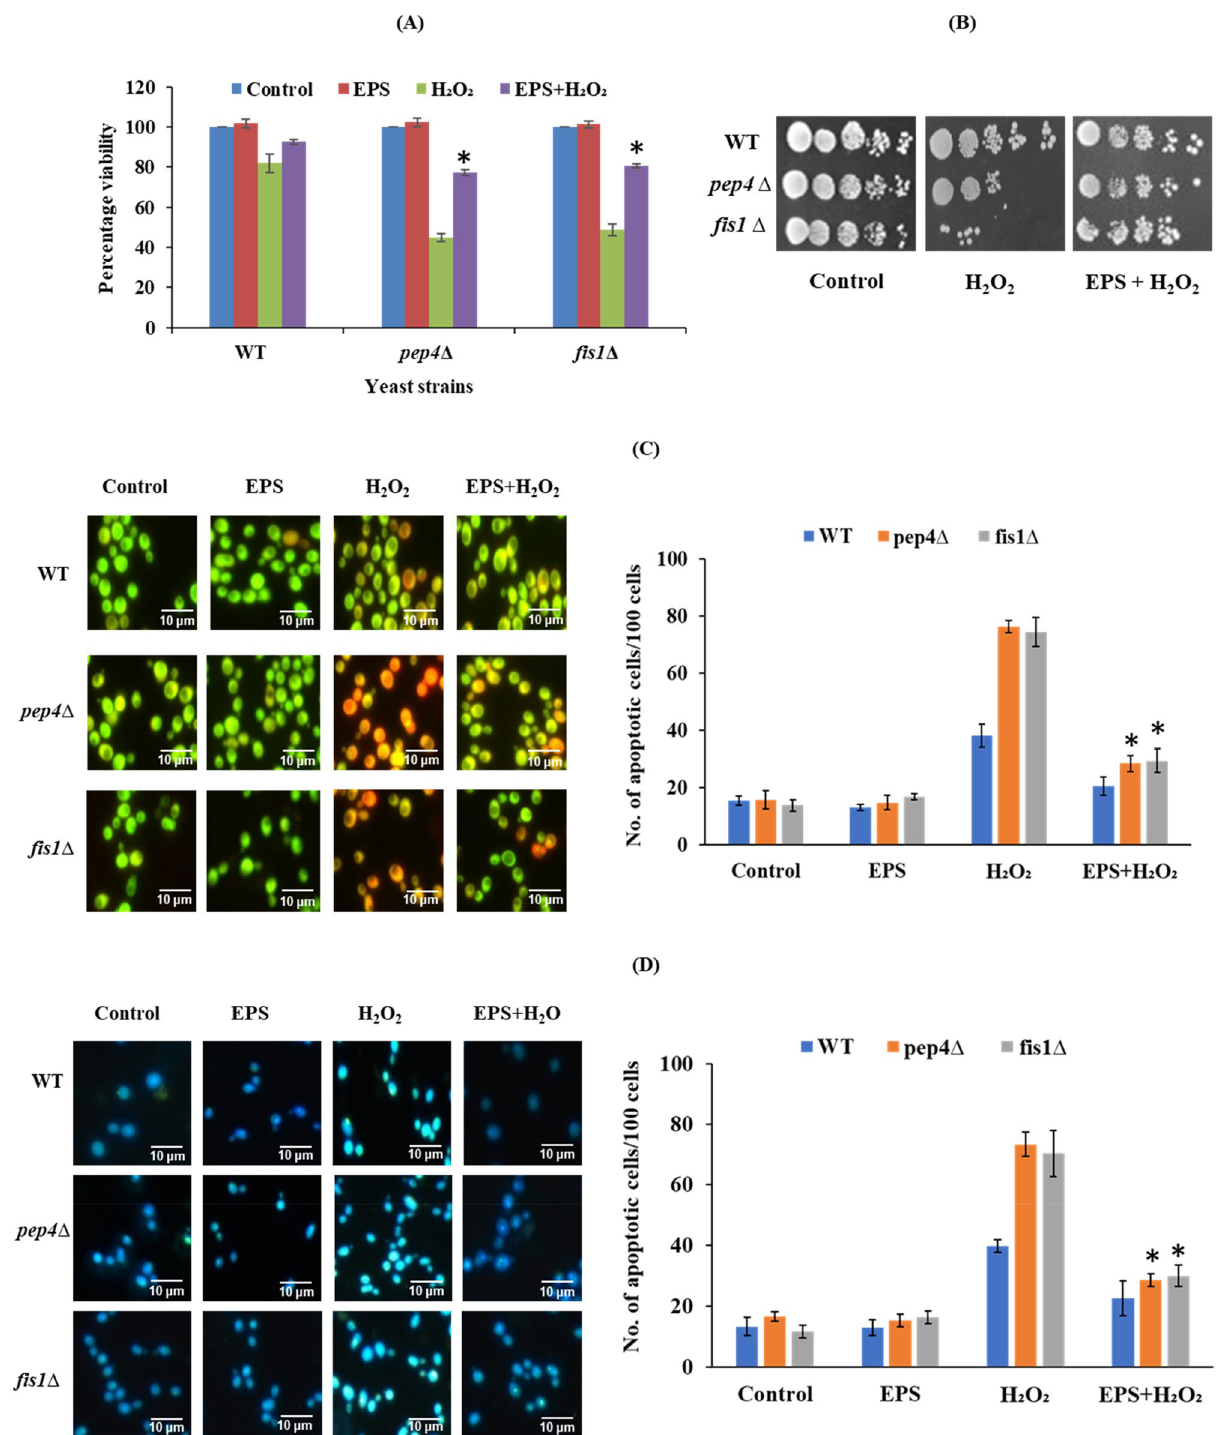
Figure 5. Anti-apoptotic activity of galactan EPS in yeast mutants ( pep4∆ and fis1∆ ). WT and mutants were pre-treated with or without EPS for 2 h followed by exposed to H 2 O 2 for 1 h, later cells were serially diluted and performed ( A ) Viability and ( B ) Spot assay. ( C ) Detection of apoptotic markers: Yeast cells were treated with or without EPS for 2 h followed by treatment with or without H 2 O 2 for 1 h. Cells were stained with fluorescence dyes specific to apoptosis and observed under a fluorescence microscope. And AO/EB staining: Chromatin condensation was observed by AO/EB staining and the number of apoptotic cells/100 cells were counted and plotted as a graph. ( D ) DAPI Staining: Nuclear fragmentation was observed by DAPI staining and the number of apoptotic cells/100 cells were counted and plotted as a graph. Data are mean ± SD of three independent experiments. * represents P < 0.0001 a significant increase in EPS + H 2 O 2 treated samples compare to those treated with EPS alone. Images shown are of at least three independent